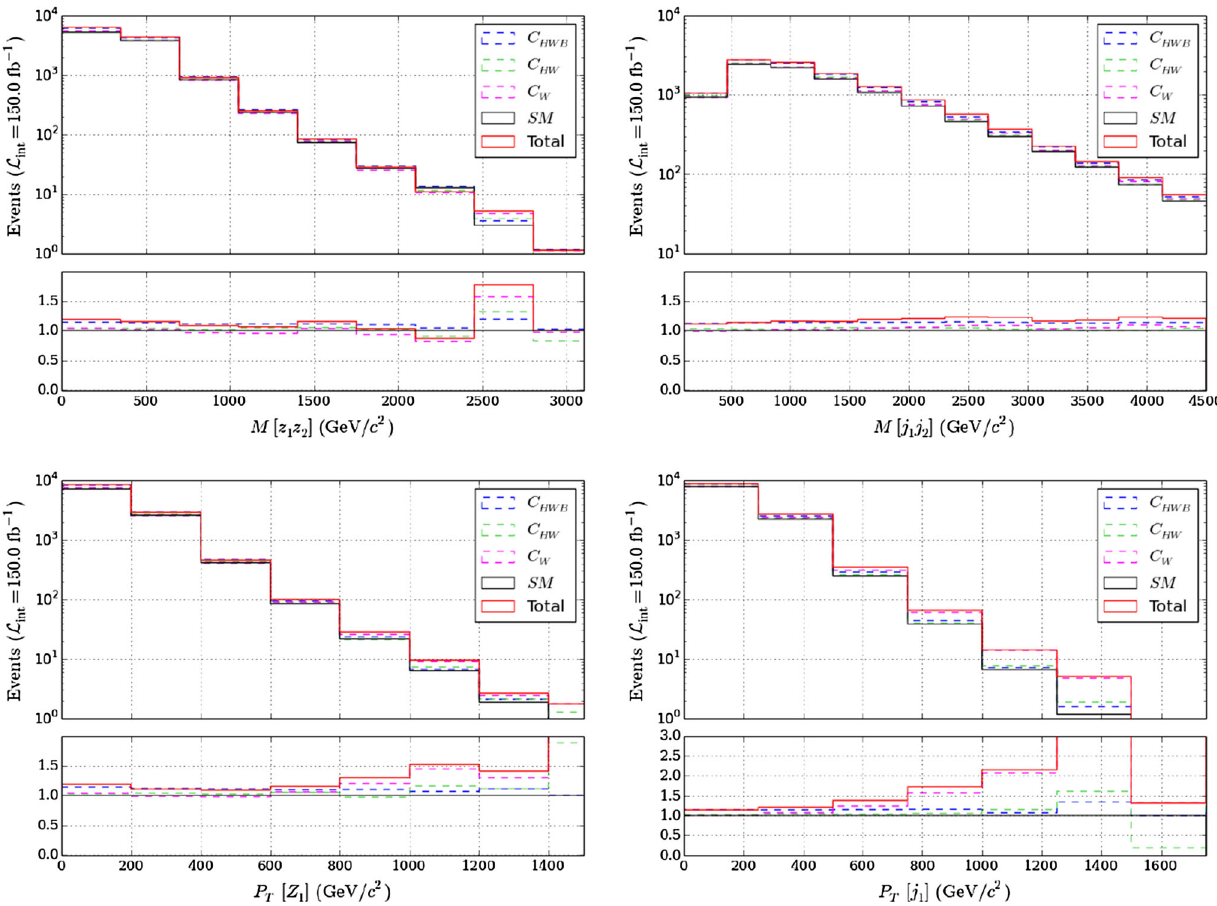
Fig. 2 Here we show the impact of the three Warsaw-basis operators that affect the triple and quartic gauge couplings. We set the values ¯ c = c v 2 = 0 . 06, which correspond to c = 1 for (cid:2) = 1 TeV. How- (cid:2) 2